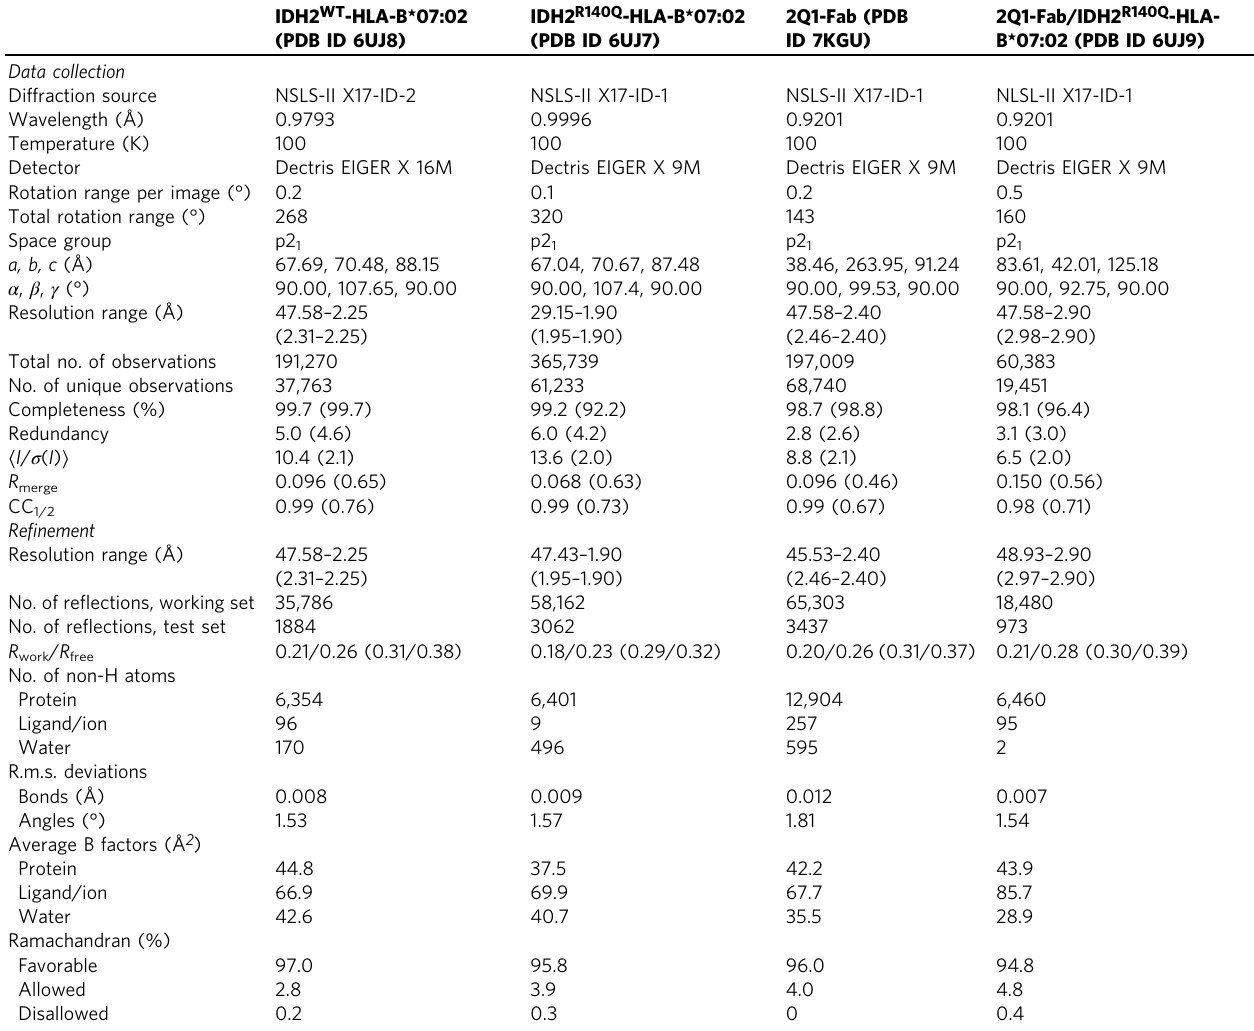
Table 1 Data collection and re fi nement